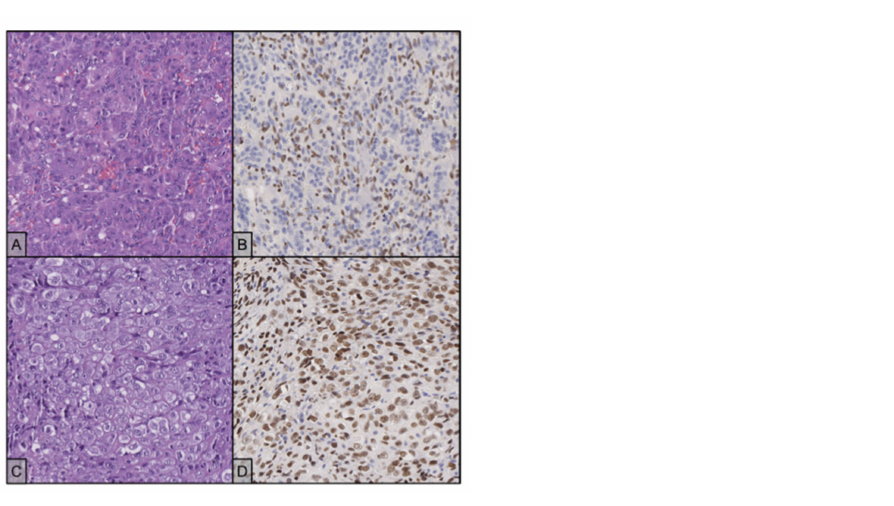
Figure 8. ( A ) The primary disease shows typical histology with osteoclast-like giant cells between numerous mononuclear cells (H&E stain, 20 × ); the two populations showed remarkably similar nuclear features, delicate nucleoli and finely dispersed chromatin; the interposed stroma appeared haemorrhagic. ( B ) Mononuclear cells react with an antibody against H3F3A, while the giant cells are negative (20 × ). ( C ) Recurrent disease shows different morphological features and no evidence of giant cells (H&E stain, 20 × ). ( D ) Neoplastic cells maintain positivity for H3F3A immunostaining (20 ×